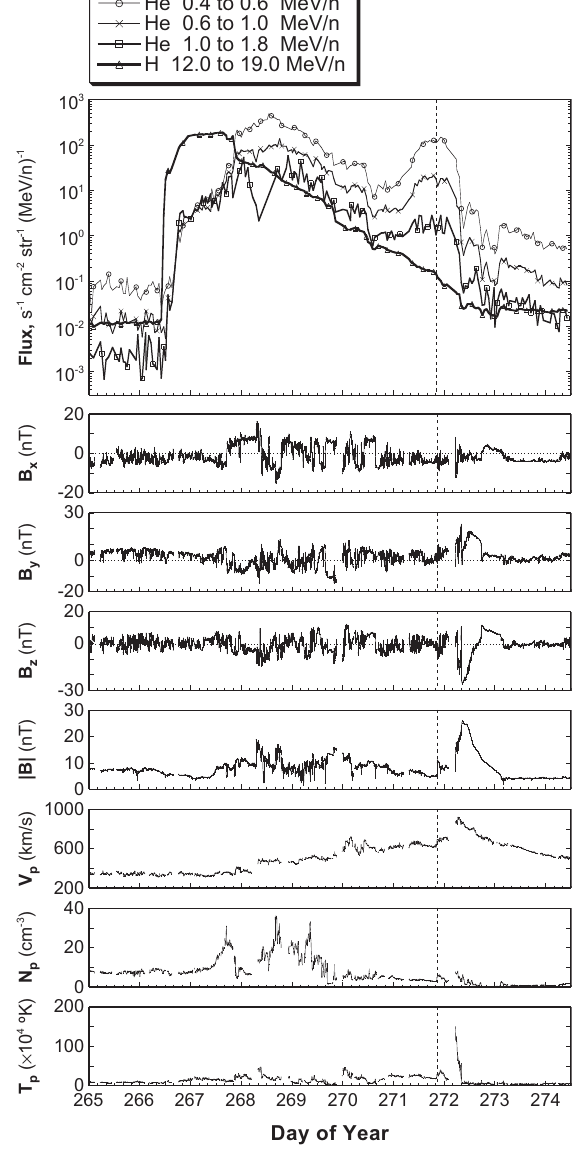
Fig. 12. A high flux energetic 12 to 19MeV proton event, associ- ated with an interplanetary shock (vertical dashed line), on day 157, 1979.